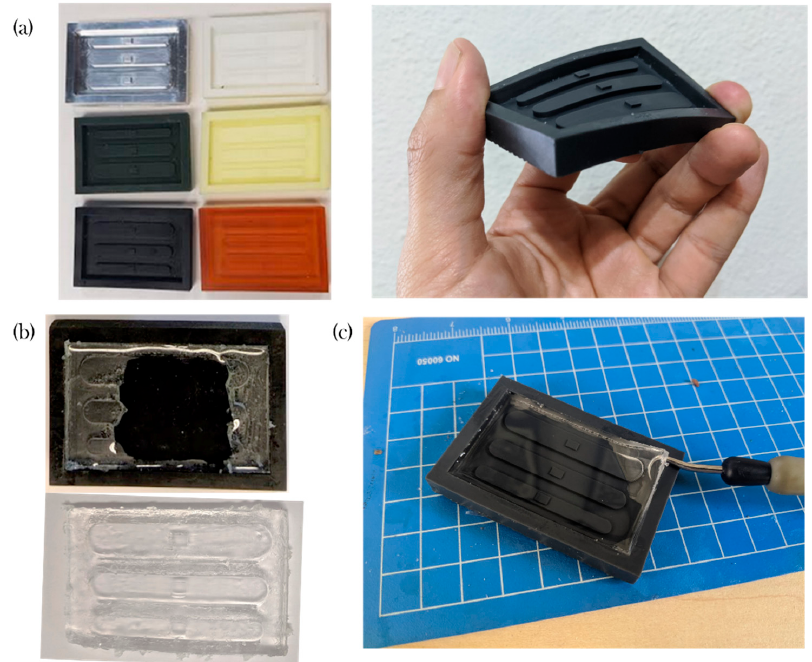
Figure 4. Assessment of material compatibility; ( a ) Picture of sample molds); ( b ) Demolding difficulties; ( c ) Polydimethylsiloxane (PDMS) slab removal on a Flexible v02 mold. ( c ) Polydimethylsiloxane (PDMS) slab removal on a Flexible v02 mold.